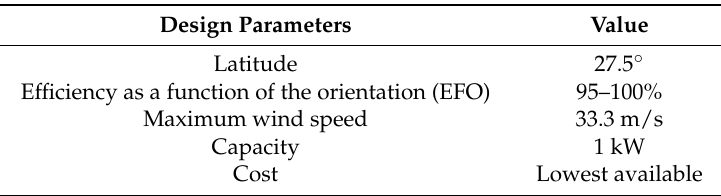
Table 1. Solar tracker design parameters.